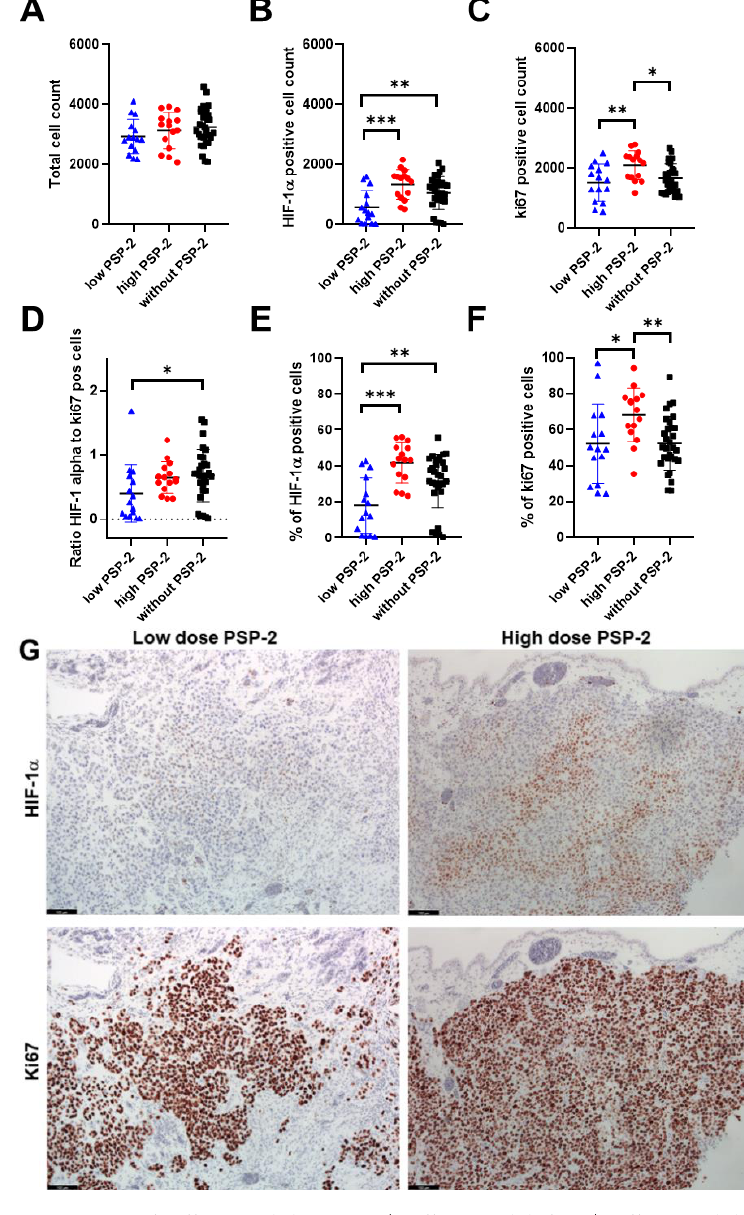
Figure 4. Total cell count ( A ), HIF-1 α + cell count ( B ), ki67 + cell count ( C ), ratio of HIF-1 α + cells to ki67 + cells ( D ), percentage of HIF-1 α + cells from total cell count ( E ), percentage of ki67 + cells from total cell count ( F ), and typical immunohistochemically stained sections for HIF-1 α ( upper row ) and ki67 ( lower row ); low-dose PSP-2 ( left column ), high-dose PSP-2 ( right column ) ( G ). One-way ANOVA was computed and pairwise comparison probabilities p were calculated using the Fisher’s PLSD post hoc test, with p < 0.05 as significance level. Key: p < 0.05 (*), p < 0.01 (**), and p < 0.001 (***). Scale bar 100 µ